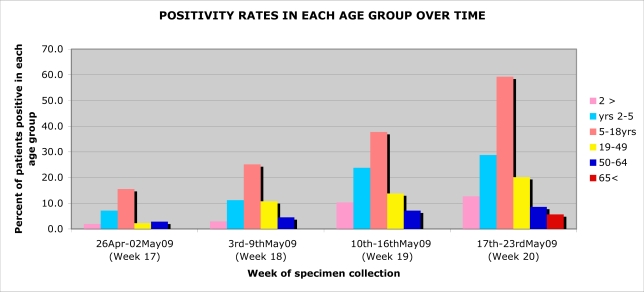
Percent patient positivity by age group and week of enhanced surveillance.